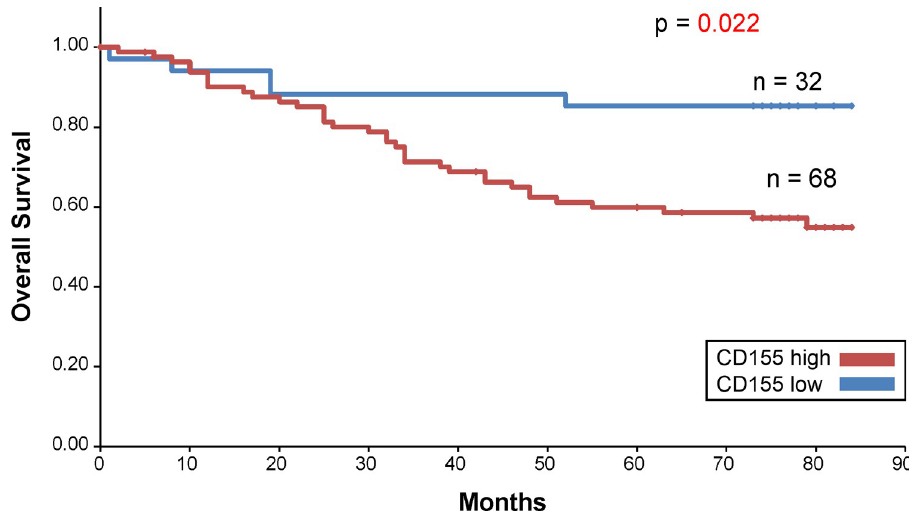
Fig 5. Overall survival curve for